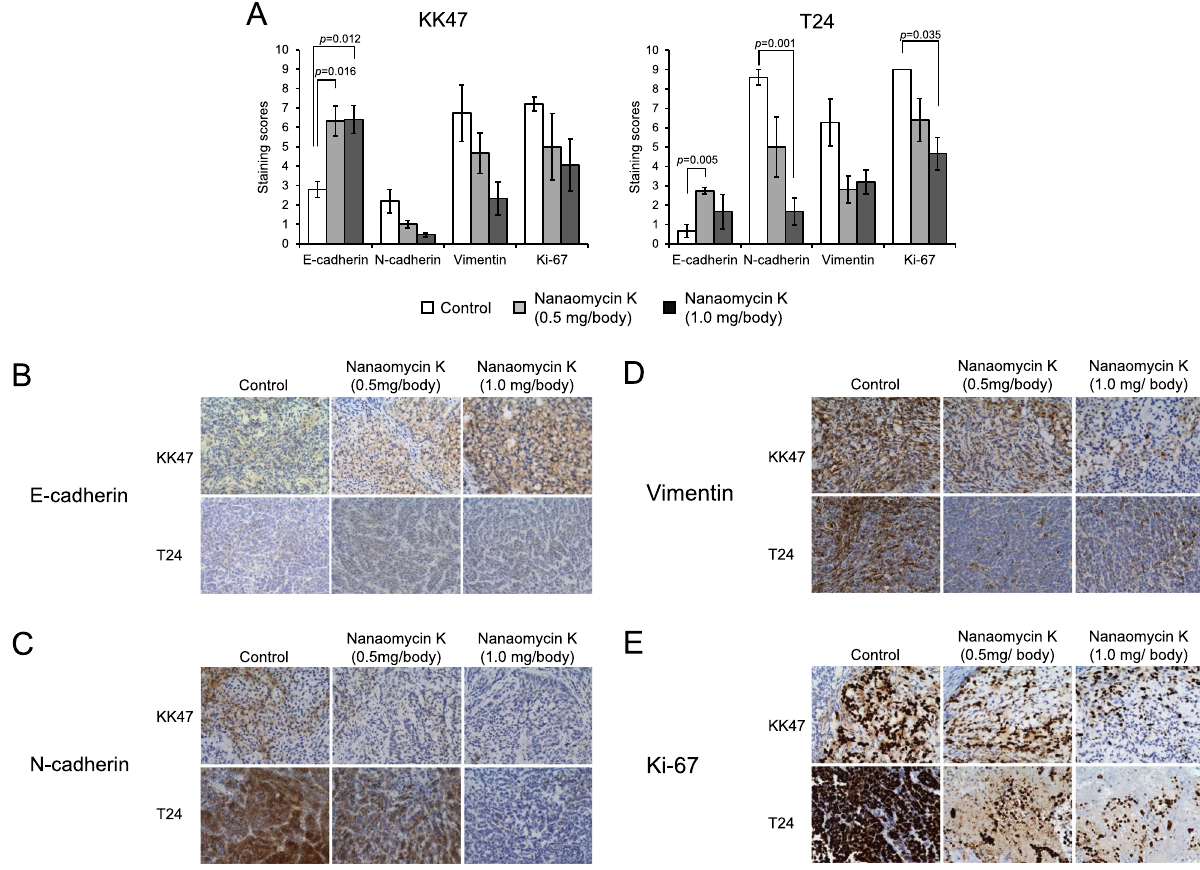
Figure 7. ( A – E ) Immunohistochemical analysis of KK47 and T24 mouse tumors for EMT markers and Ki-67 after nanaomycin K treatment. Marker expressions of E-cadherin, N-cadherin, vimentin and Ki-67 in tumor tissues were determined by immunohistochemical staining and evaluated by staining score (0–9) ( A ). Representative images for each marker is shown in ( B ) E-cadherin, ( C ) N-cadherin, ( D ) vimentin, ( E ) Ki-67,